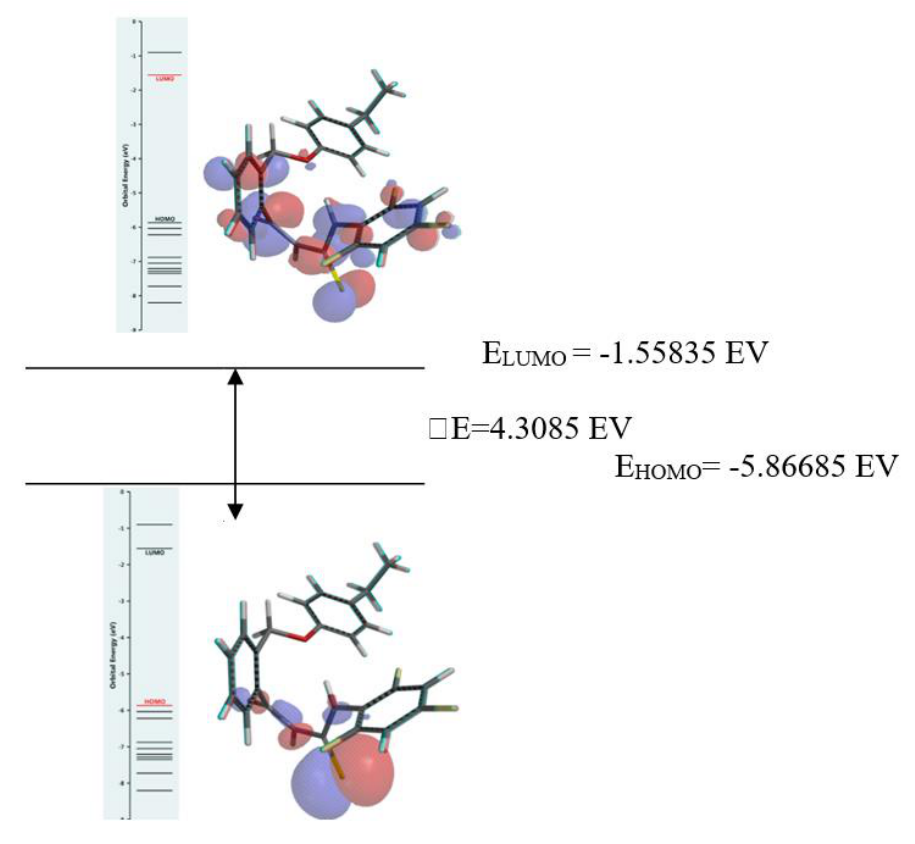
Figure 4. Highest occupied molecular orbital (HOMO) and lowest unoccupied molecular orbital (LUMO) surfaces of 5d compound.